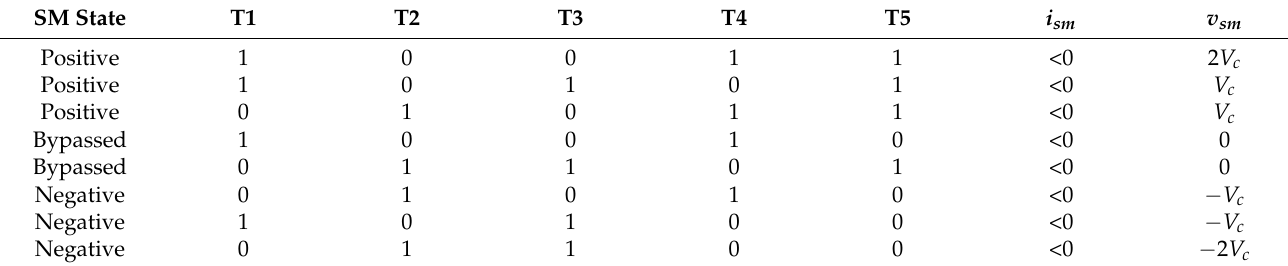
Table 8. SDSM STATCOM Mode Switching States.